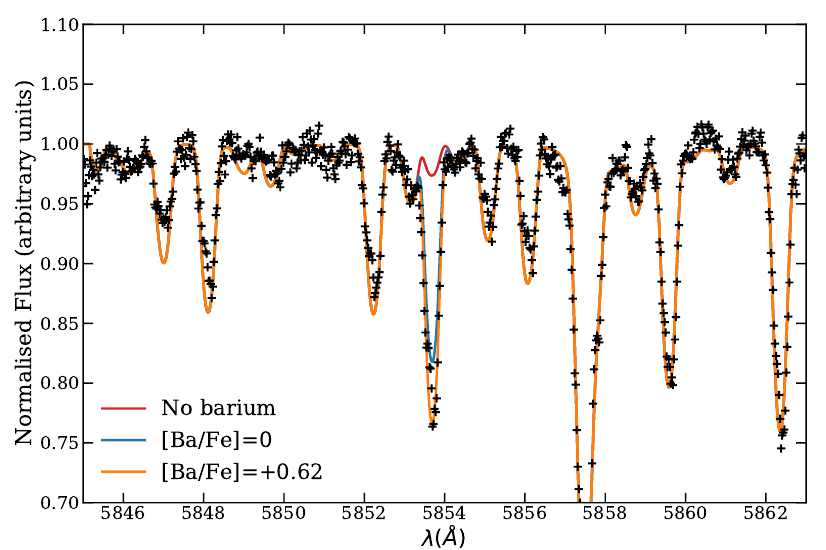
Figure 3. Comparison between observed (black crosses) and synthetic profiles around the Ba II line at 5853 Å for star RZ Psc.